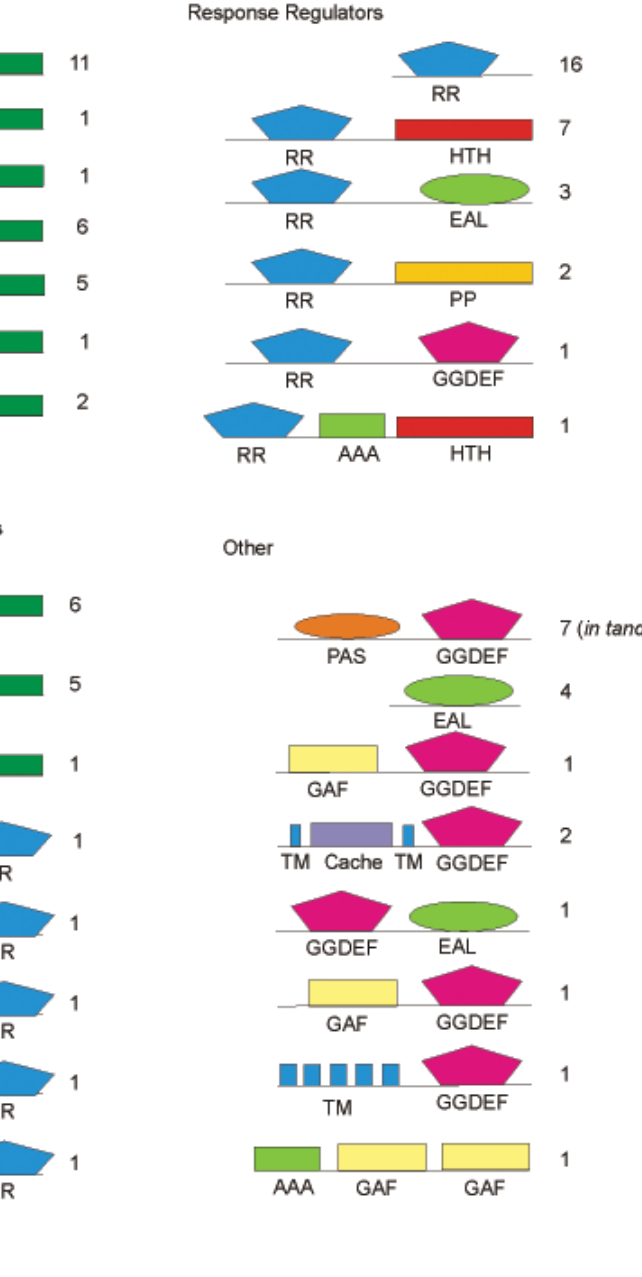
Figure 5. Domain architecture of putative signal transduction proteins from Leptospira interrogans. The domain organization of histidine kinases, response regulators, hybrid histidine kinase/response regulators and other peptides probably associated with signal transduction is shown schematically. The number of peptides containing each domain organization is shown on the right, and the genes are found distributed over the large or small replicons, except for the seven peptides containing the PAS/GGDEF arrangement, which are encoded by genes located in tandem in the large replicon. AAA = ATPase; Cache = small ligand binding domain; EAL = phosphodiesterase; GAF = cGMP-binding domain; GGDEF = diguanylate cyclase; HK = histidine kinase domain; HTH = helix-turn-helix; PAS = sensor domain (may include a PAS/PAC arrangement); PP = phosphatase; RR = response regulator domain; SP = signal peptide; TM = transmembrane